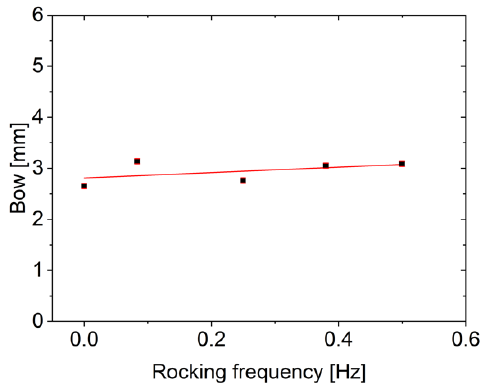
Figure 10. Bow measurements depending on the variation of the rocking frequency (y = 0.53 ( ± 0.53 ) x + 2.81 ( ± 0.16 ) ; COD (r 2 ): 0.25).